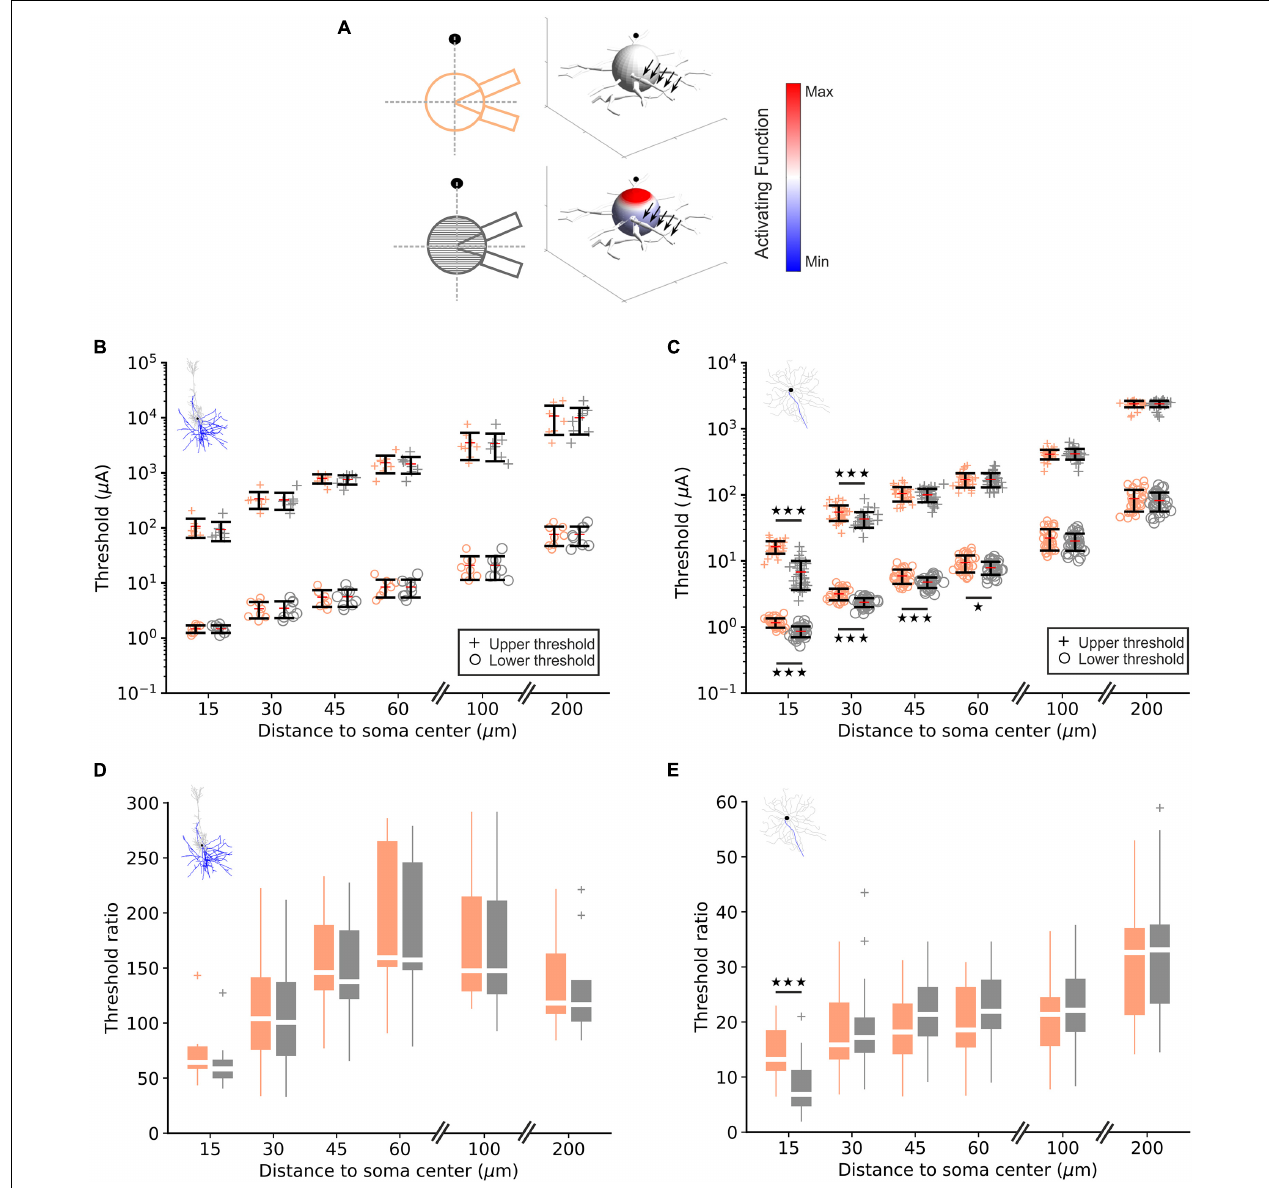
FIGURE 2 | Lower and upper threshold in RGC and PC models. (A) For one RGC and both soma configurations (left), each compartment is color-coded by its activating function in response to a 1 µ A cathodic pulse (right). The point source electrode is shown as filled black circle/sphere, black arrows indicate the axon. (B) Computed lower (“o”) and upper (“+”) thresholds for the single- (orange) and multi-compartment soma (gray) in eight PCs for different electrode distances. (C) Same as panel (B) for 34 RGCs. (D) Threshold ratio UT/LT for PCs at different electrode distances. (E) Same as panel (D) for RGCs; note the different y-scales in panels (D,E)